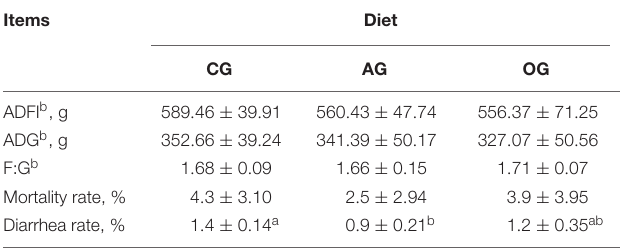
TABLE 2 | Effects of different DF on piglet a growth